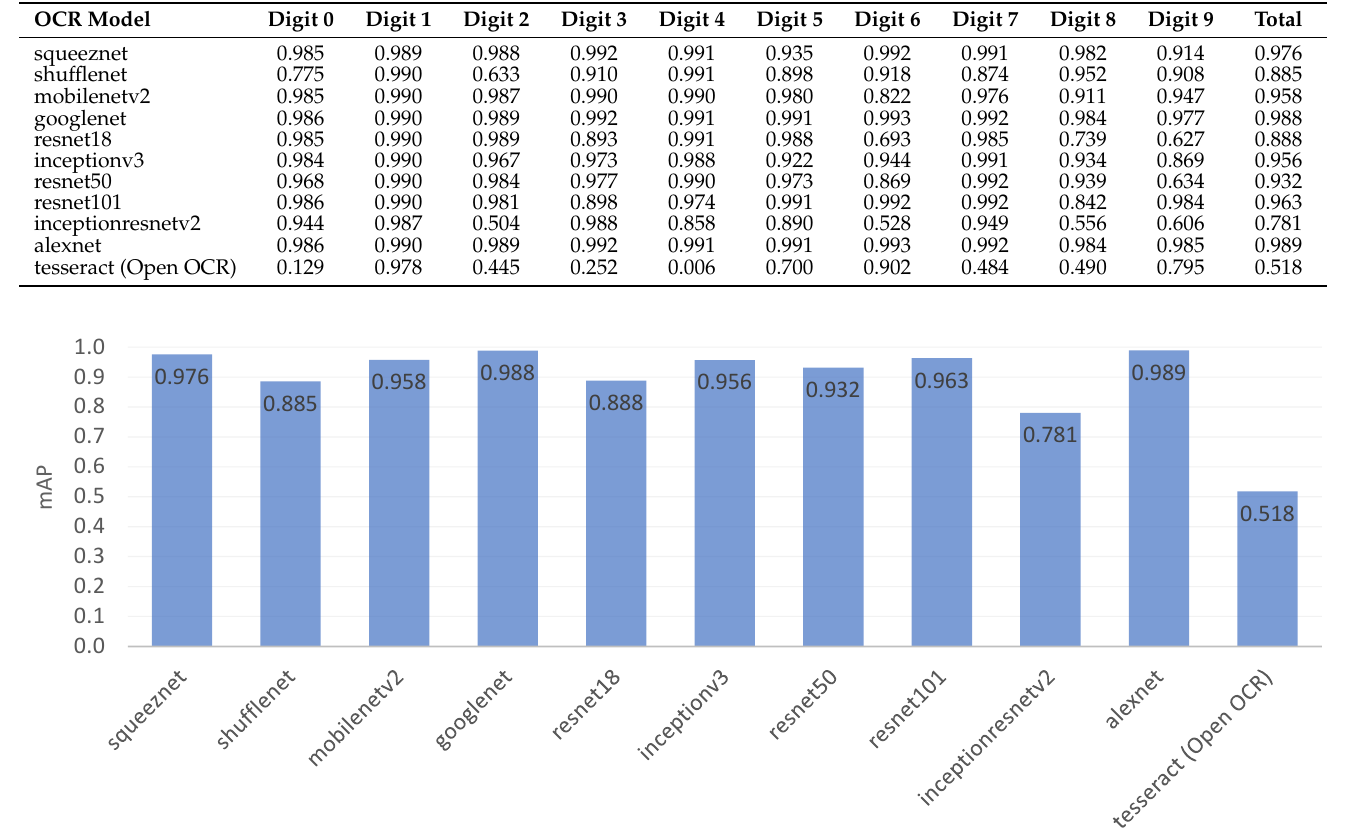
Table 5. Recognition performance ( mAP ) evaluation for evaluating the trained DL models.